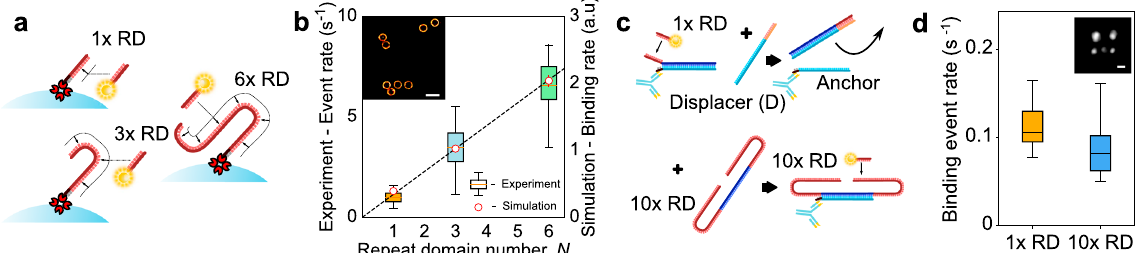
Fig. 1 Repeat DNA-PAINT preserves event rates at greatly reduced imager concentration. a Docking motifs with N = 1, 3, or 6 binding sites, here biotin- modi fi ed and anchored to streptavidin-coated microspheres. b The event rate scales linearly with N , as determined experimentally on microsphere test samples and by coarse-grained computer simulations. The dashed line is a linear fi t to the simulation results. Inset: rendered image of a selection from one set of functionalized microspheres. n = 82, 88, 68 microspheres for 1x, 3x, 6x RD, respectively. c Scheme enabling swapping between 1x RD and 10x RD docking motifs. A common anchor strand is fi rst connected to a 1x RD strand, which can be removed with a displacer strand D and replaced with a 10x RD motif. d : Application of the scheme in c on synthetic origami tiles shows the number of events per second per tile remains approximately the same with origami functionalized with either 1x or 10x RD when using nominally 10-fold decrease in imager concentration. n = 49 origami tiles (1x RD) and n = 81 origami tiles (10x RD). Boxplots show minima, maxima and median of the data. Scale bars: b 1 µ m, d 30